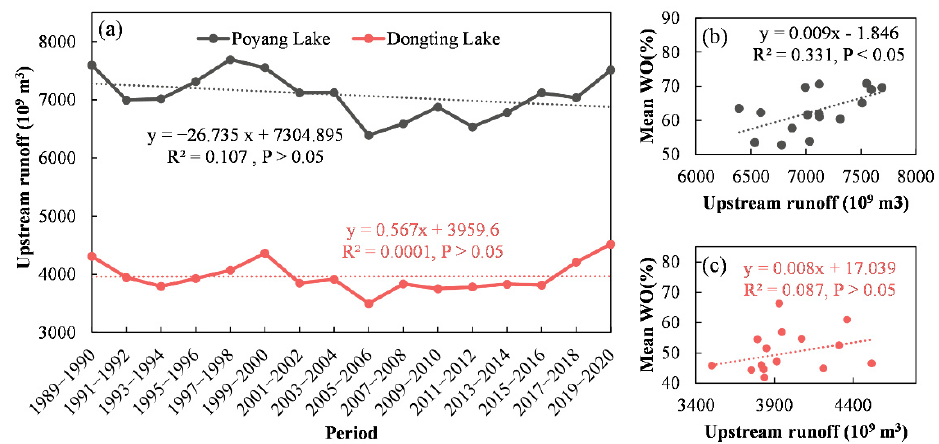
Figure 13. Upstream runoff changes in Poyang Lake and Dongting Lake. ( a ) indicates the time series of upstream runoff in Poyang Lake and Dongting Lake. ( b ) indicate the relationship between upstream runoff and mean WO in Poyang Lake. ( c ) indicate the relationship between upstream runoff and mean WO in Dongting Lake.